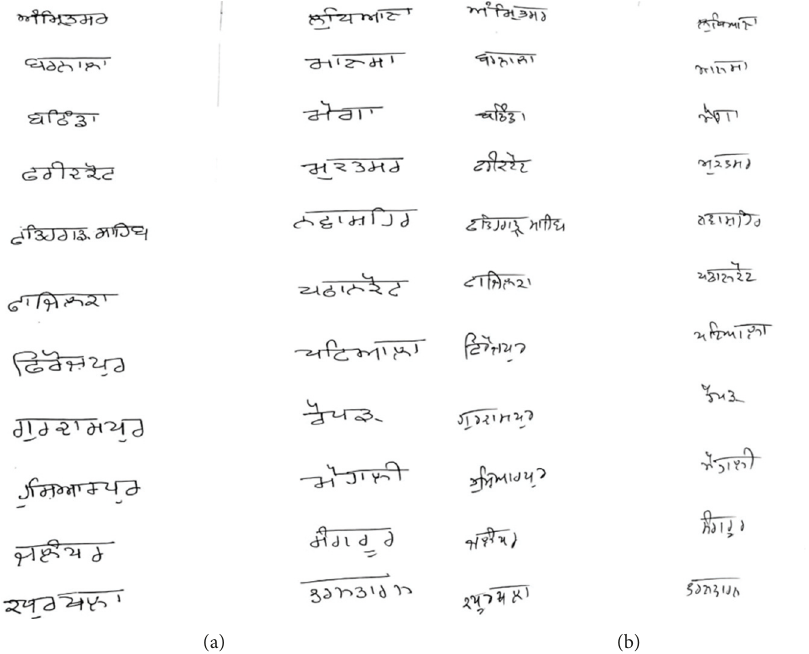
Figure 3: Scanned handwritten sheets: (a) scanned image “Sample 1” and (b) scanned image “Sample